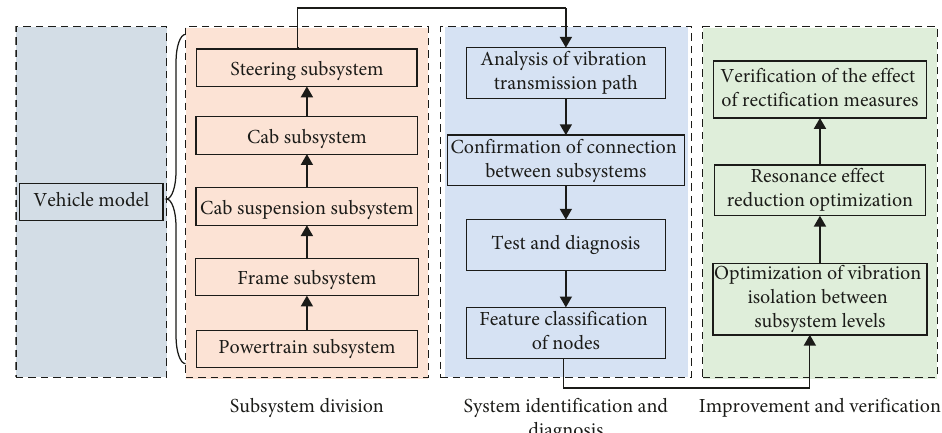
Figure 2: Method implementation flow